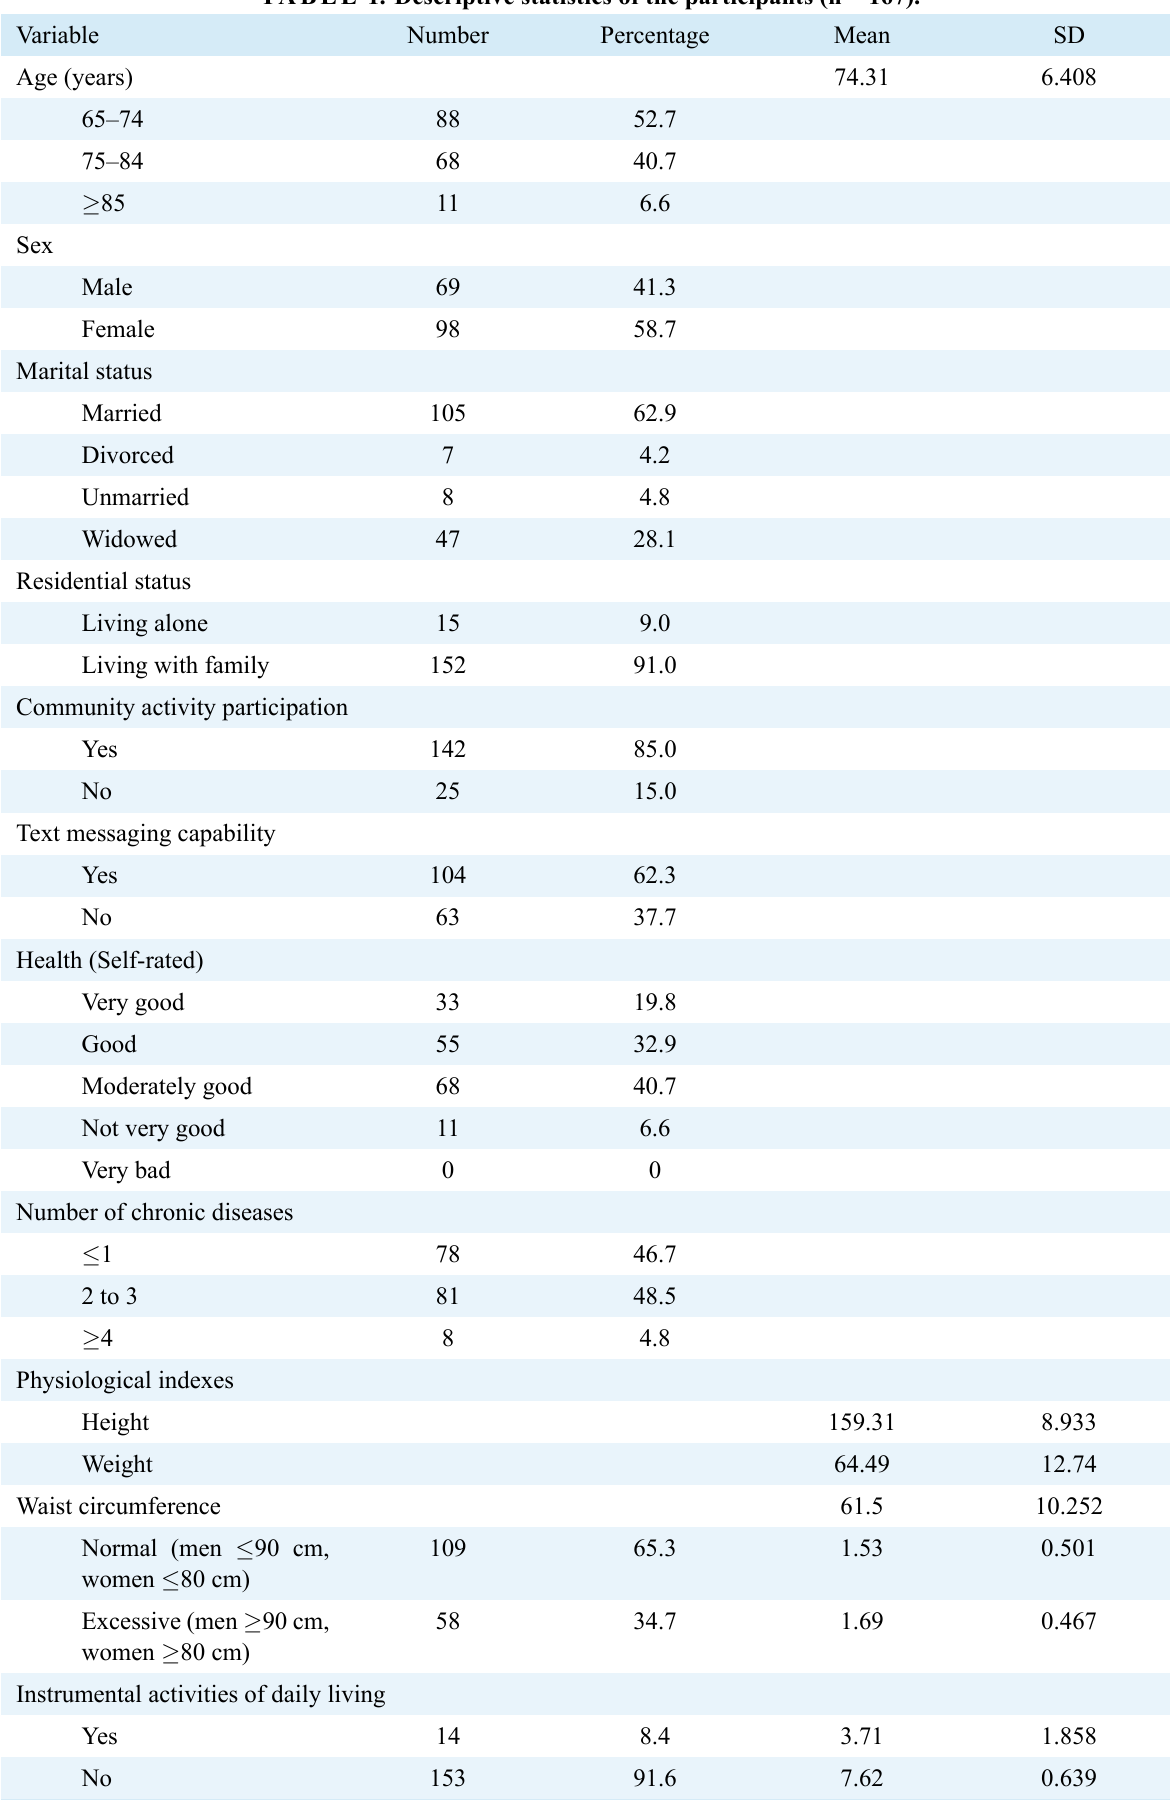
TABLE 1. Descriptive statistics of the participants (n =